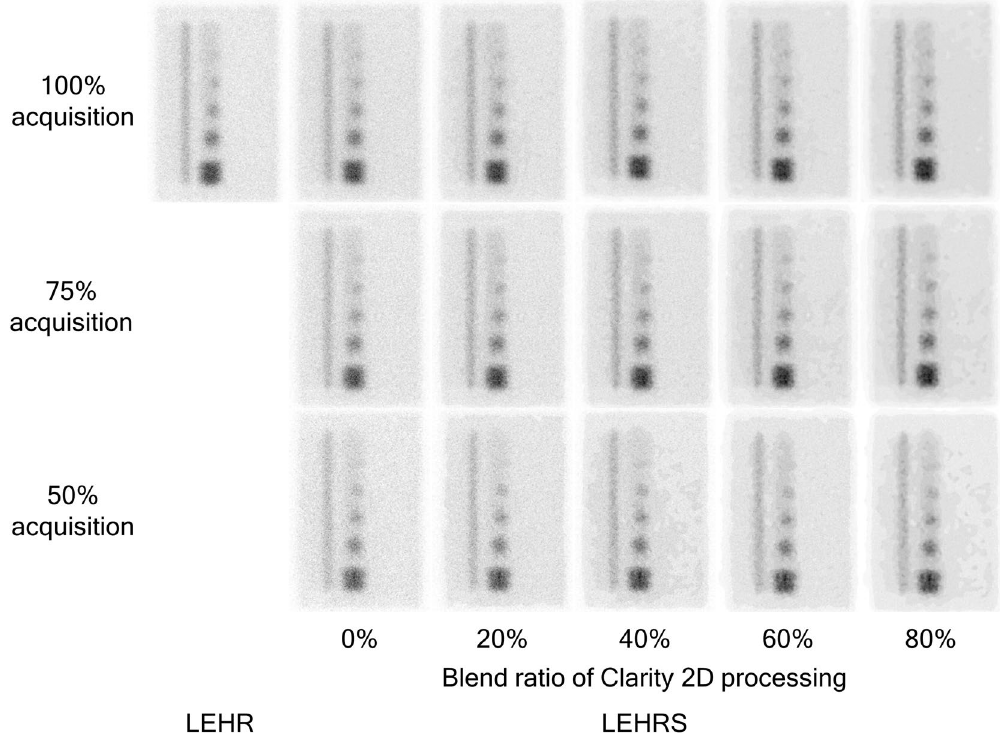
Figure 5. The phantom image of SwiftScan planar processing. Upper, middle and lower rows show the 100%, 75% and 50% acquisition time, respectively. The 100% acquisition corresponds to the clinical condition. LEHR low-energy high-resolution, LEHRS low-energy high-resolution and sensitivity.